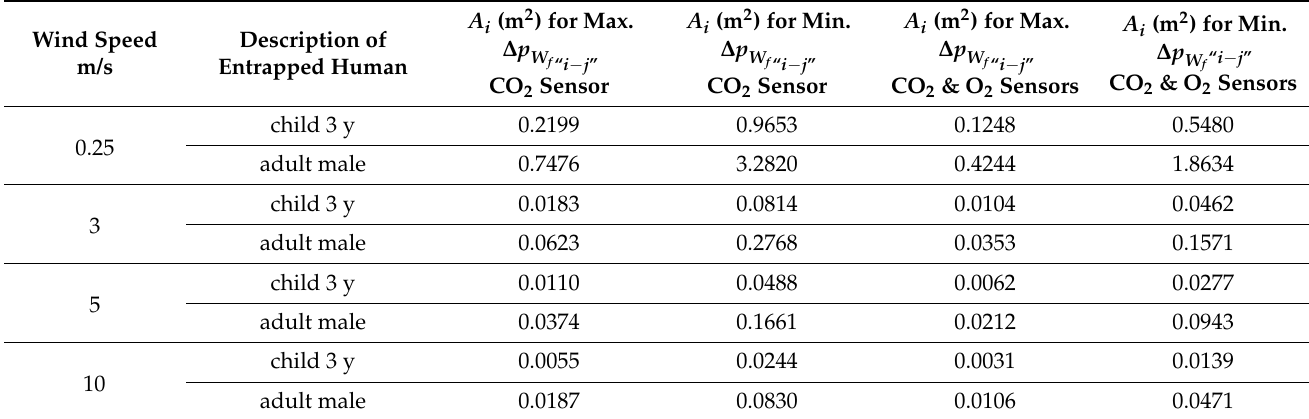
Table 6. Estimation of maximum total possible area of large openings in voids (Urban/Suburban). Wind